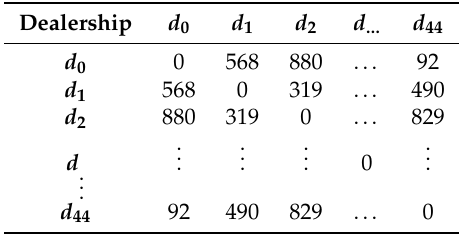
Table 2. Travel times (in minutes) between dealerships.